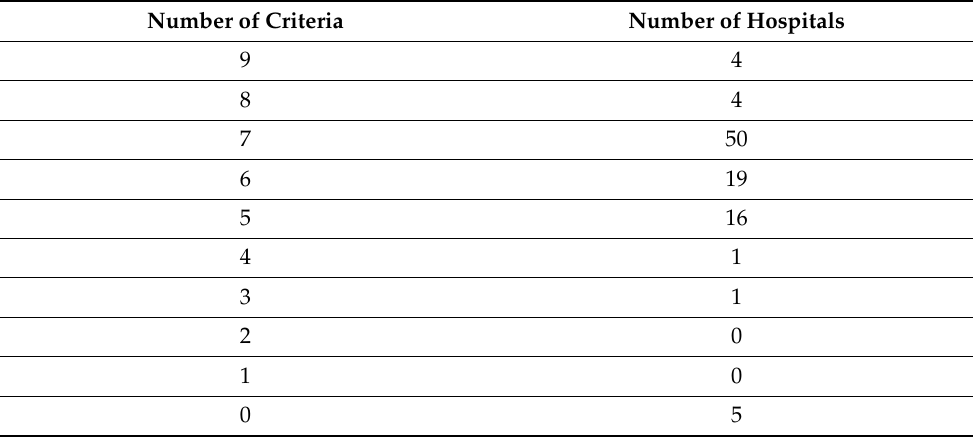
Table 3. Hospitals and